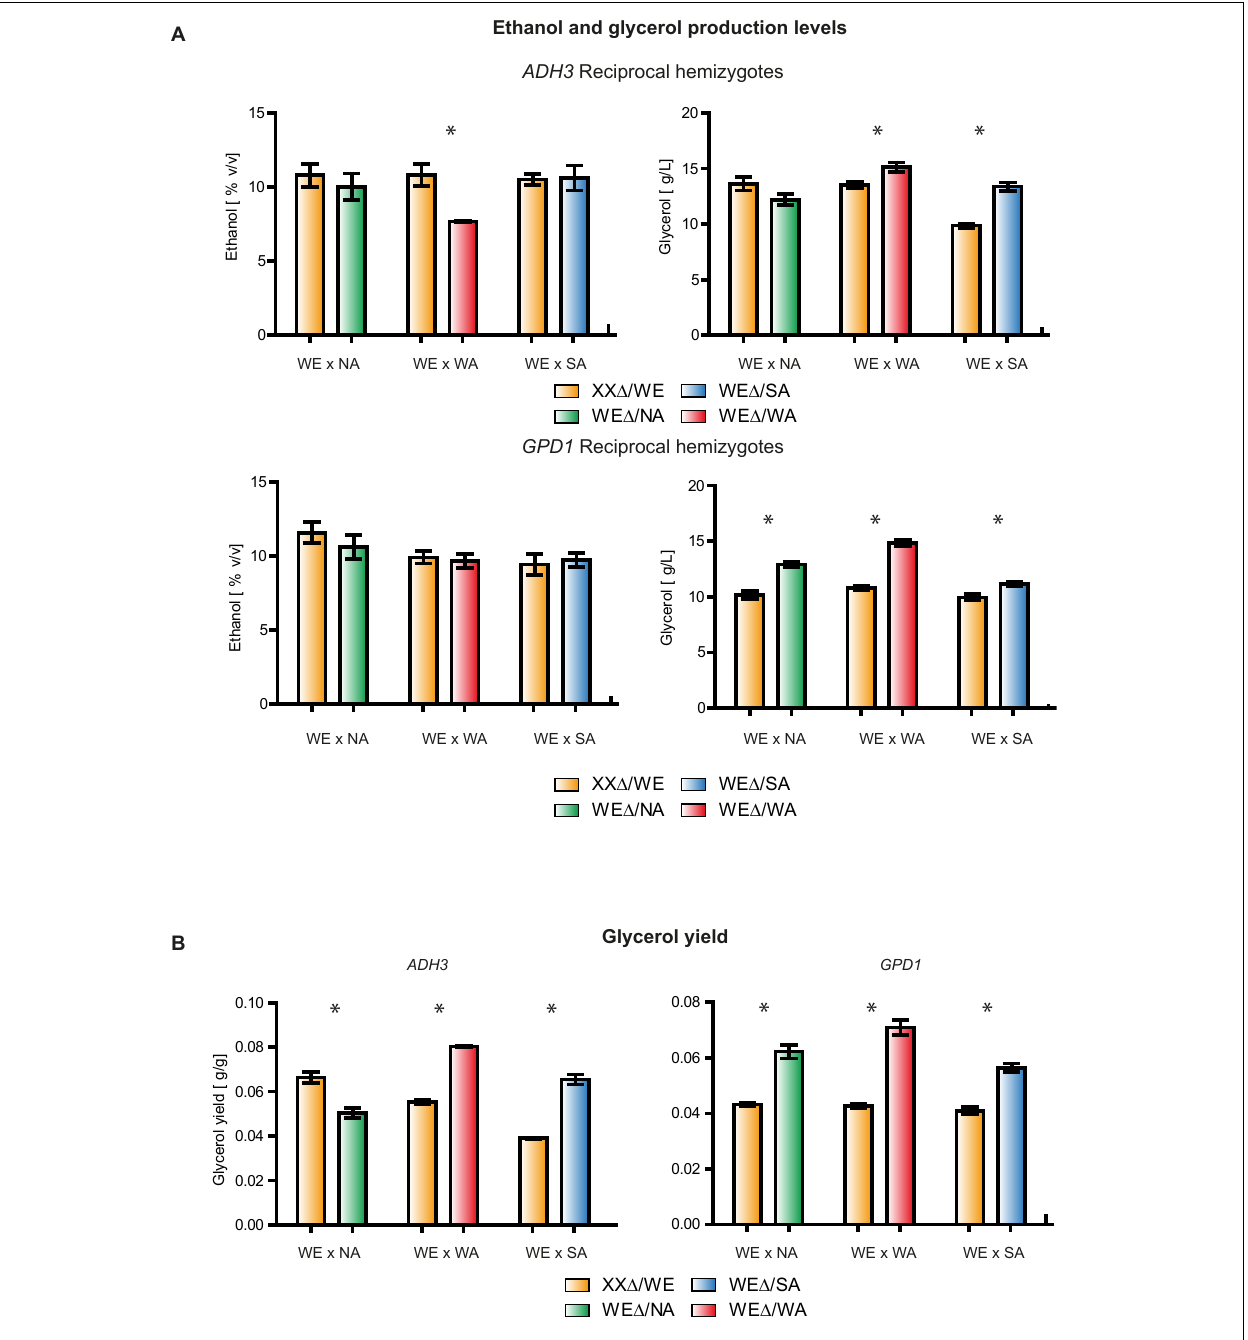
FIGURE 2 | Reciprocal hemizygosity assay for GPD1 and ADH3 . (A) Ethanol (%v/v) and Glycerol (g/L) levels in WE × NA, WE × SA, and WE × WA reciprocal hemizygotes. The Glycerol yield for the same strains is shown in (B) . XX denotes either the NA, WA, or SA genotype depending on the bar. ∗ p -value <